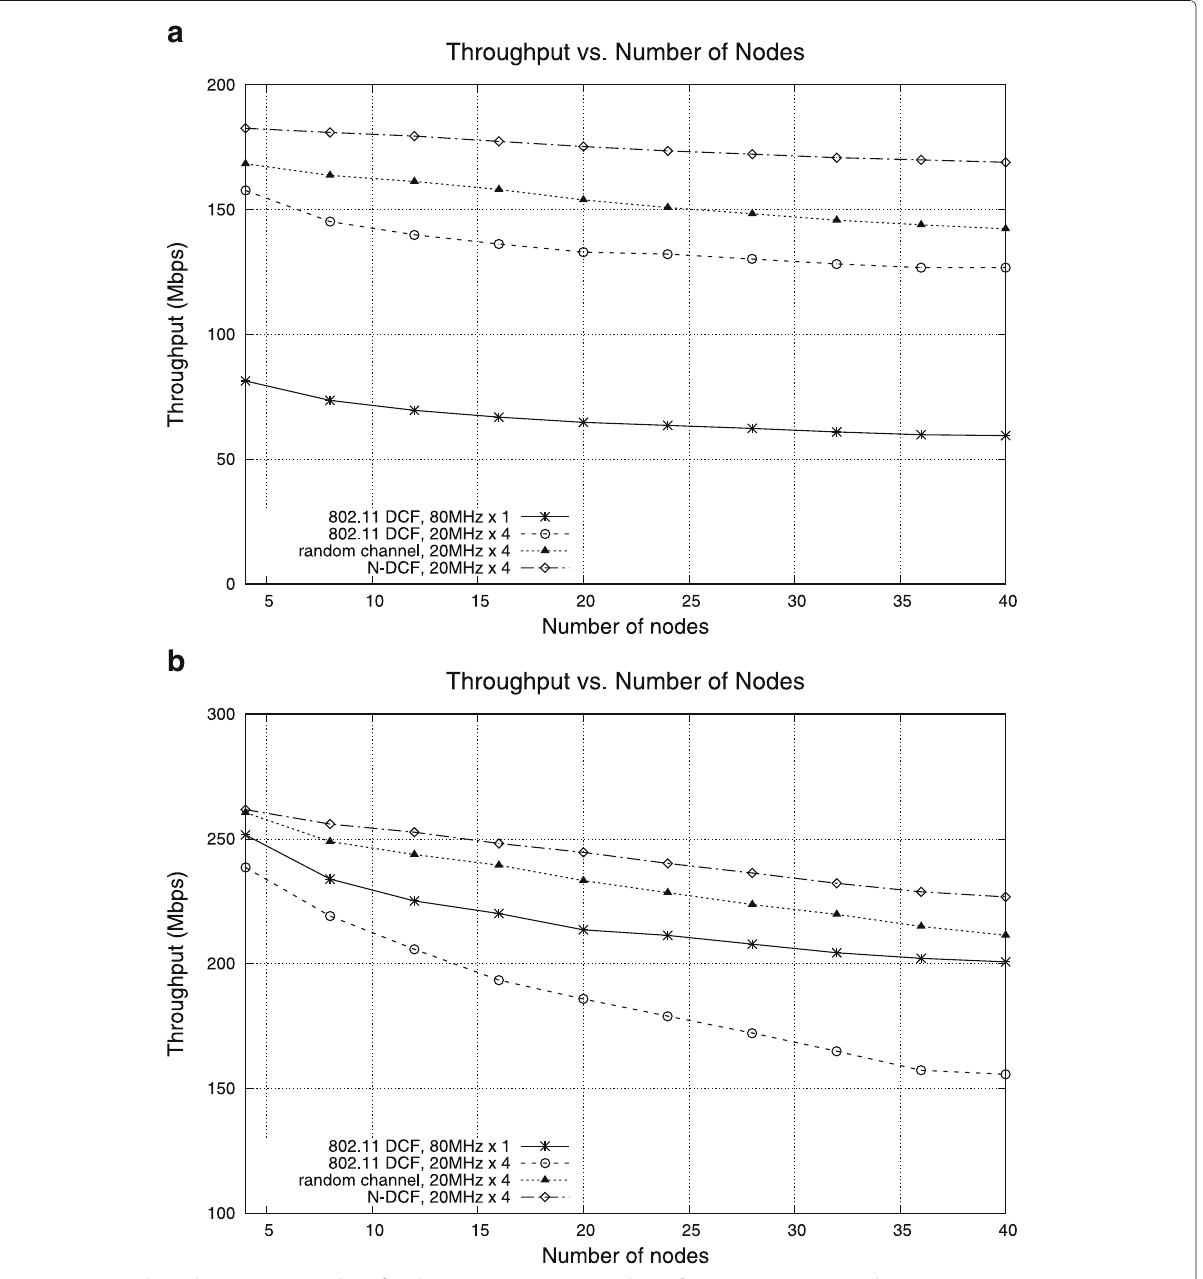
Fig. 10 Average throughput varying number of nodes. a A-MPDU size = 3000 bytes. b A-MPDU size = 65,535 bytes